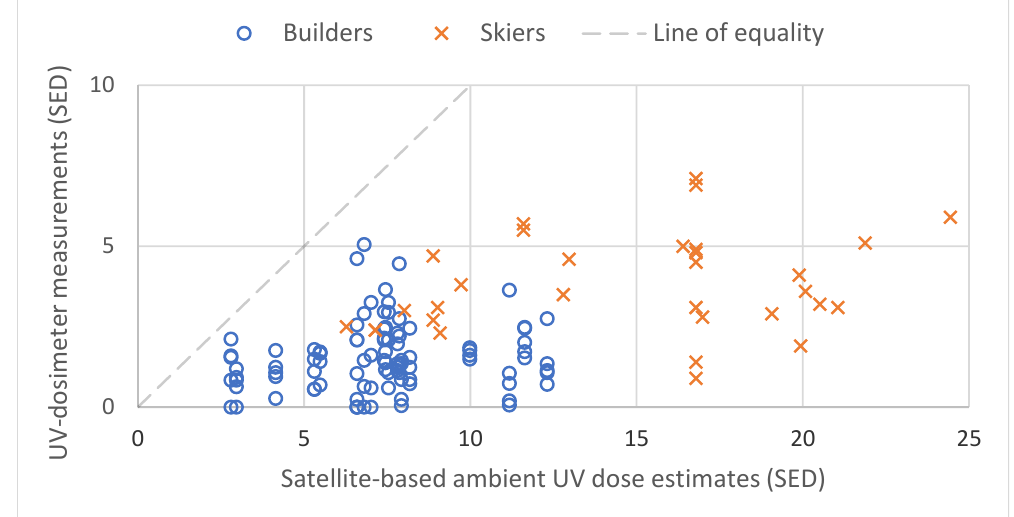
Figure 1. Scatter plot demonstrating the relationship between satellite-based ambient ultraviolet (UV) dose estimates and dosimeter-measured doses for builders and skiers. Note that no points exceed the line of equality.